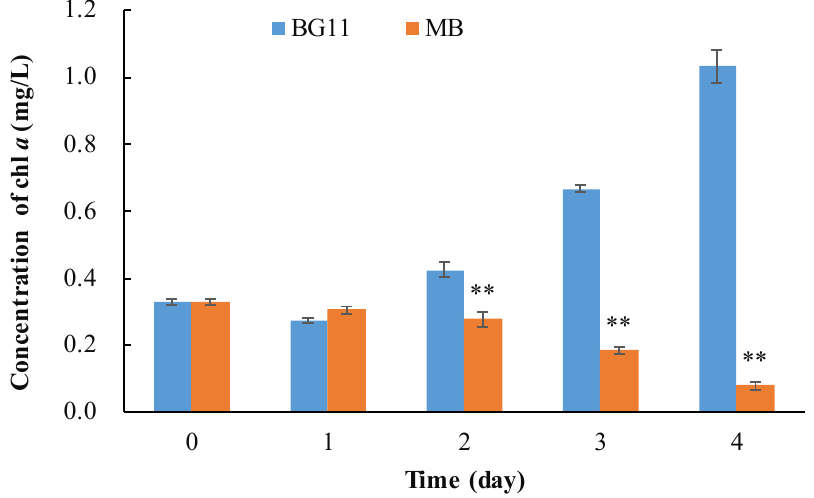
Figure 1. Algicidal effect of B. laterosporus on M. aeruginosa . (** Represents significant differences to control group at the 0.01 probability level.)